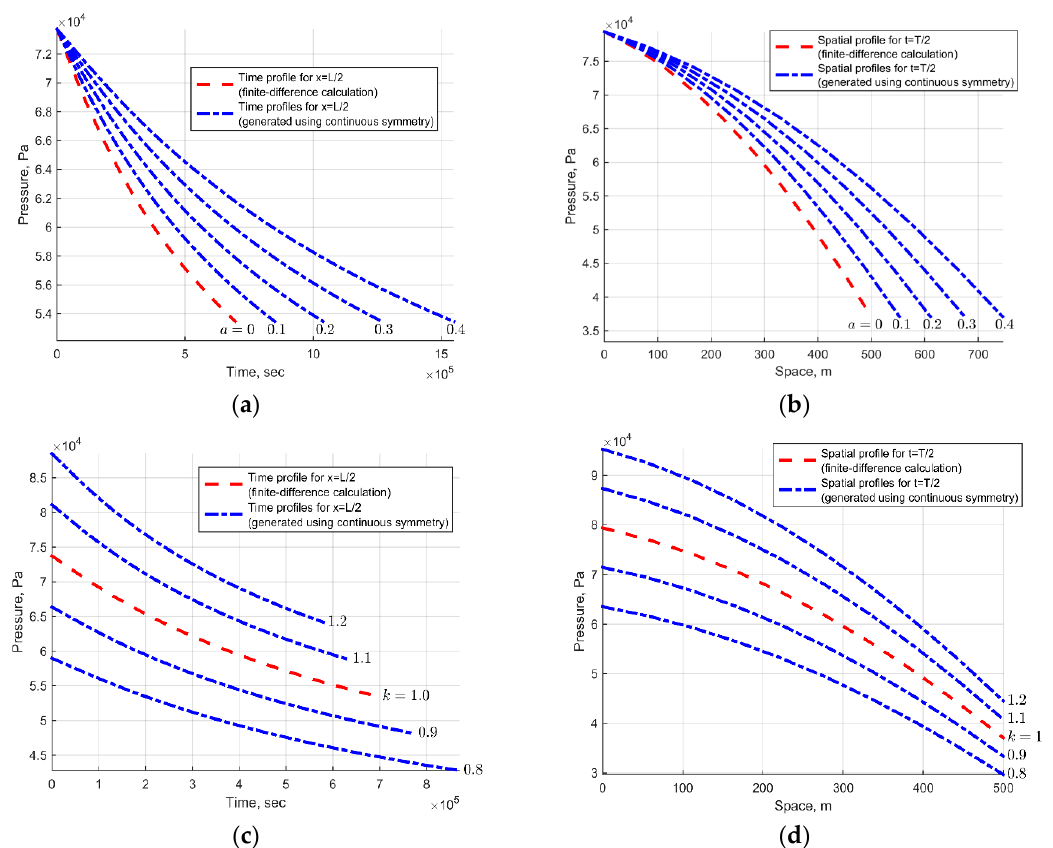
Figure 2. Numerical solution generations for the solution (Figure 1) obtained using the implicit scheme with the time step choice. Plots ( a , b ) show generations using dilations for time and spatial variables (infinitesimal operator X 3 ) with certain values of the group parameter a ; plots ( c , d ) show the applications of X 4 , which defines dilations of time and the combination of dilations and translations for pressure (the set initial left boundary pressures define group parameters for generations, where k is the factor for P left ).